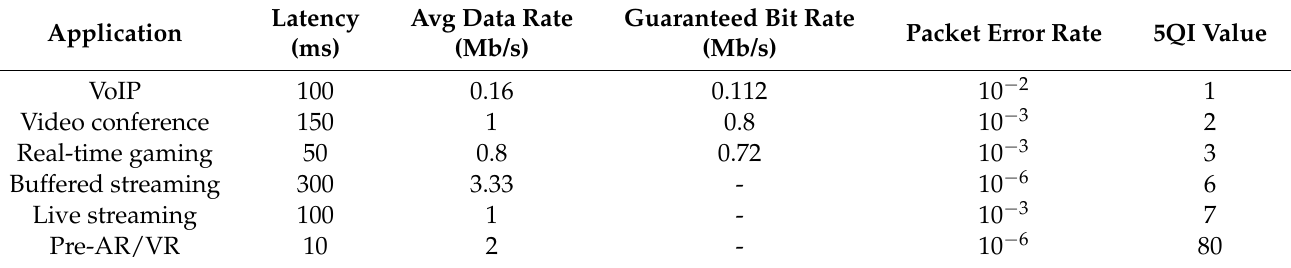
Table 4. Requirements for traffic types. 5QI, 5G QoS class